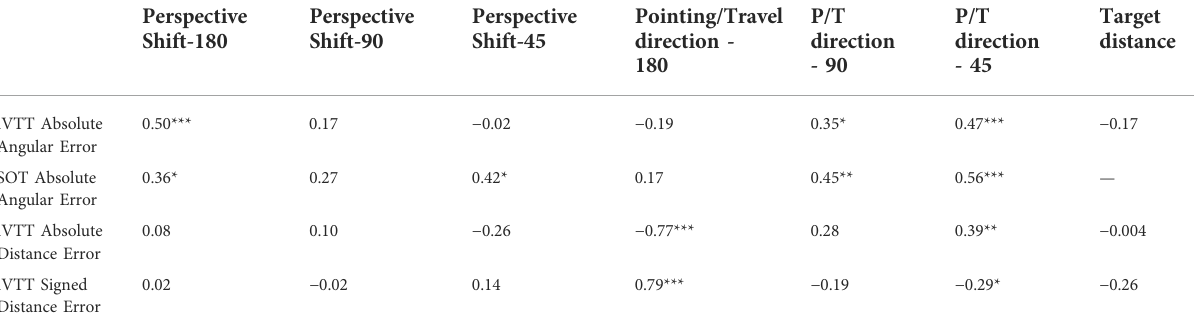
TABLE 5 Linear correlation tables between all measures and trial